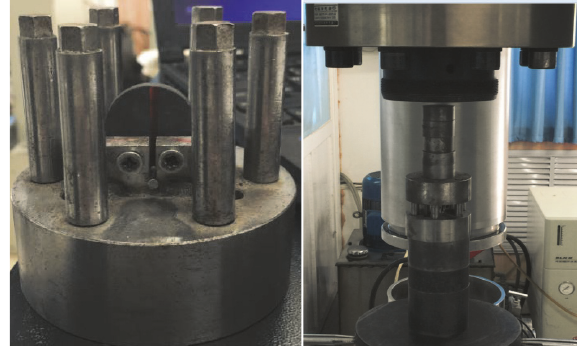
Figure 5: Brazilian splitting test